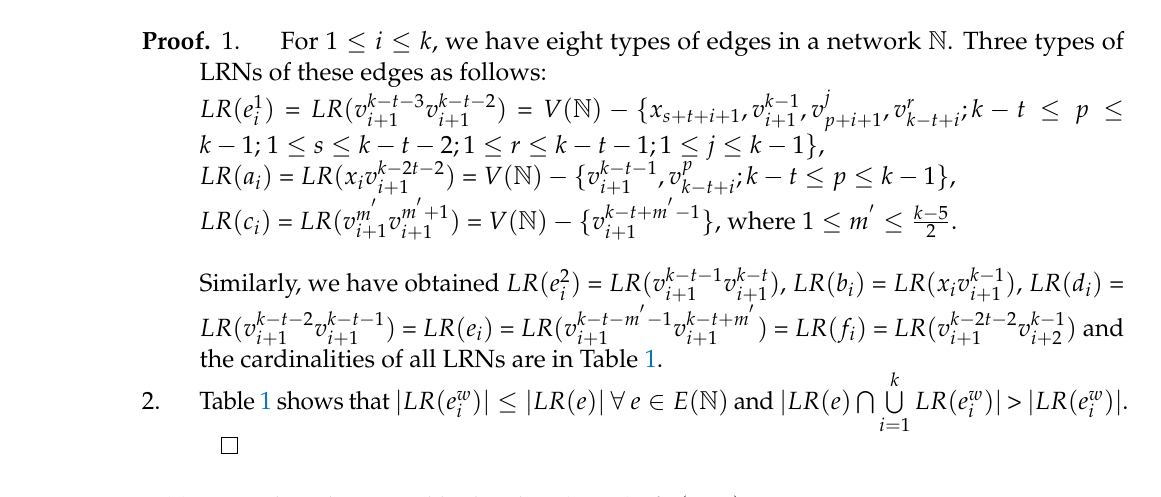
Table 1. Local resolving neighborhood set (LRNs) of S ( 2, C k )